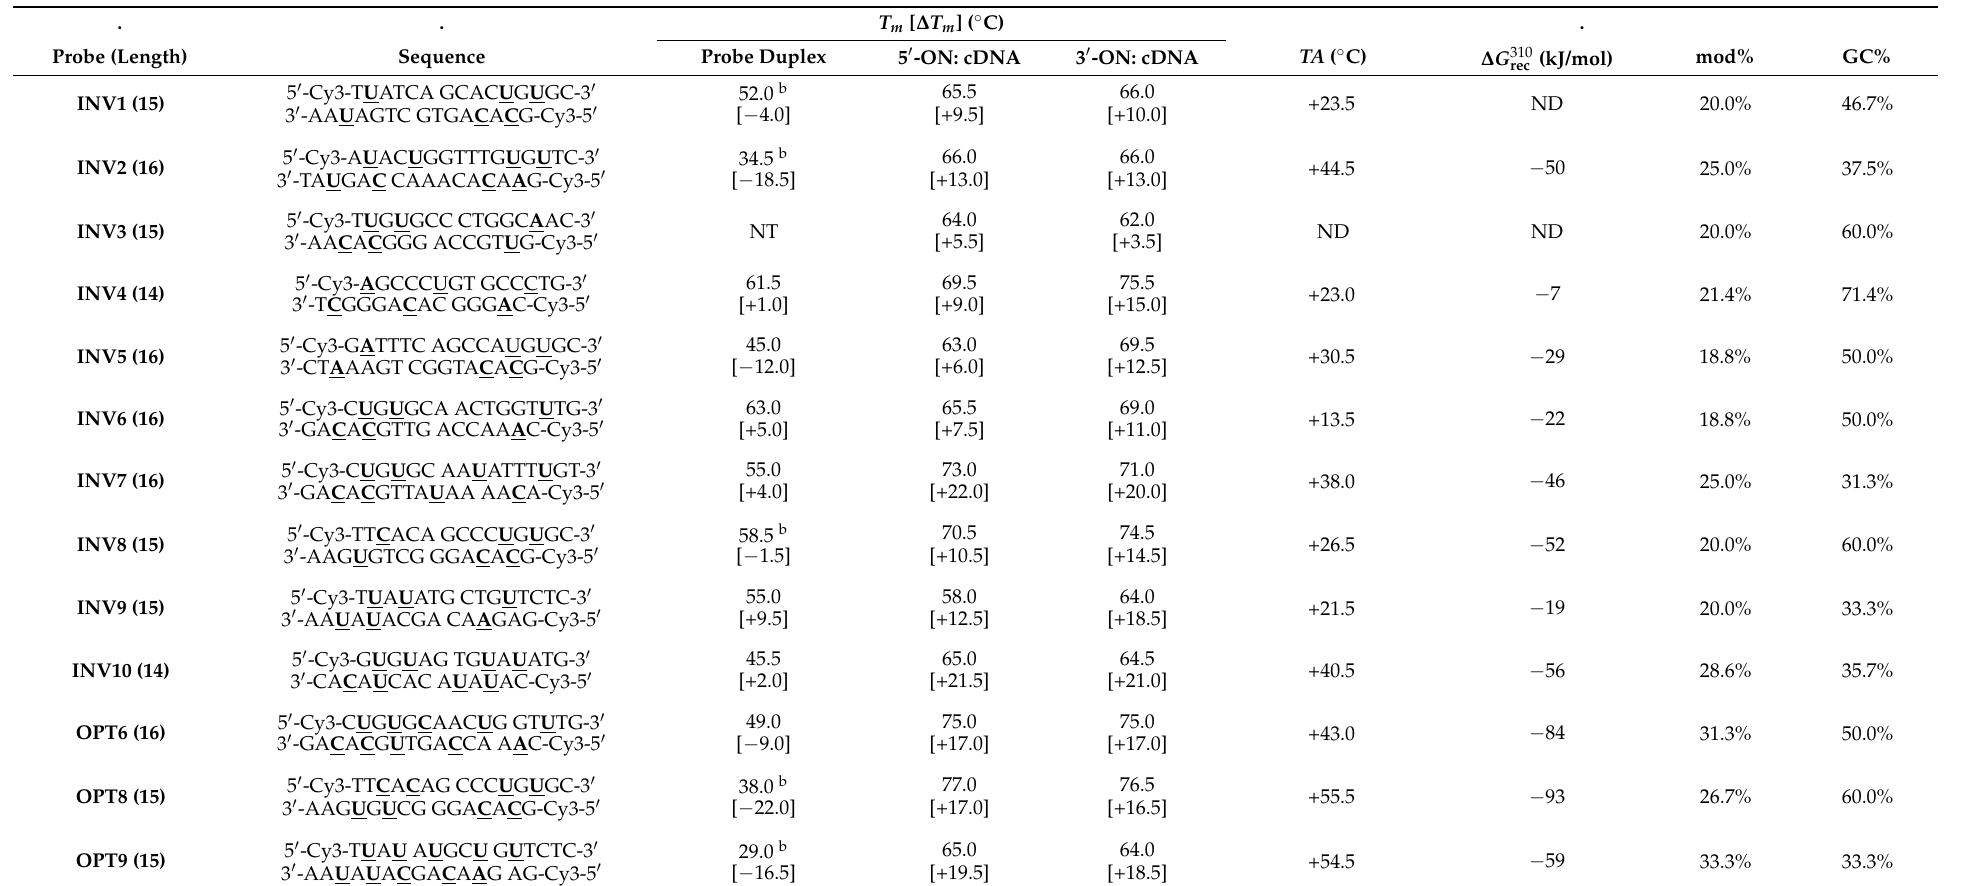
Table 1. Thermal denaturation temperatures ( T m s) of Invader probes and duplexes between individual probe strands and cDNA. Also shown are the length, thermal advantage values ( TA ), available free energy for recognition of isosequential dsDNA targets at 310 K ( ∆ G 310 rec ), modification densities (mod%), and GC-content (GC%) of Invader probes a